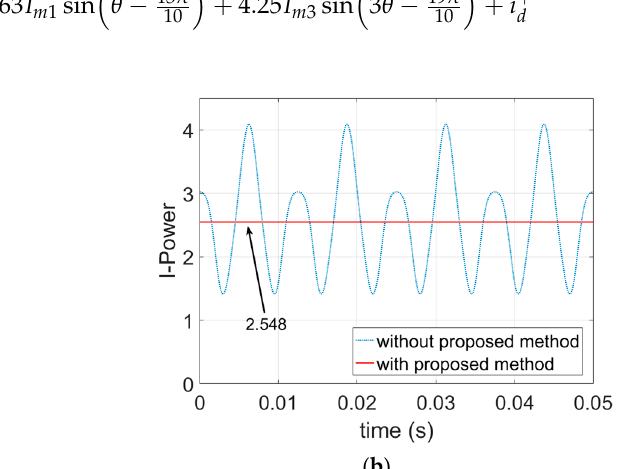
Figure 7. I-power graphs for the adjacent three-phase OCFT condition currents: ( a ) Fundamental; ( b ) fundamental plus third harmonic.